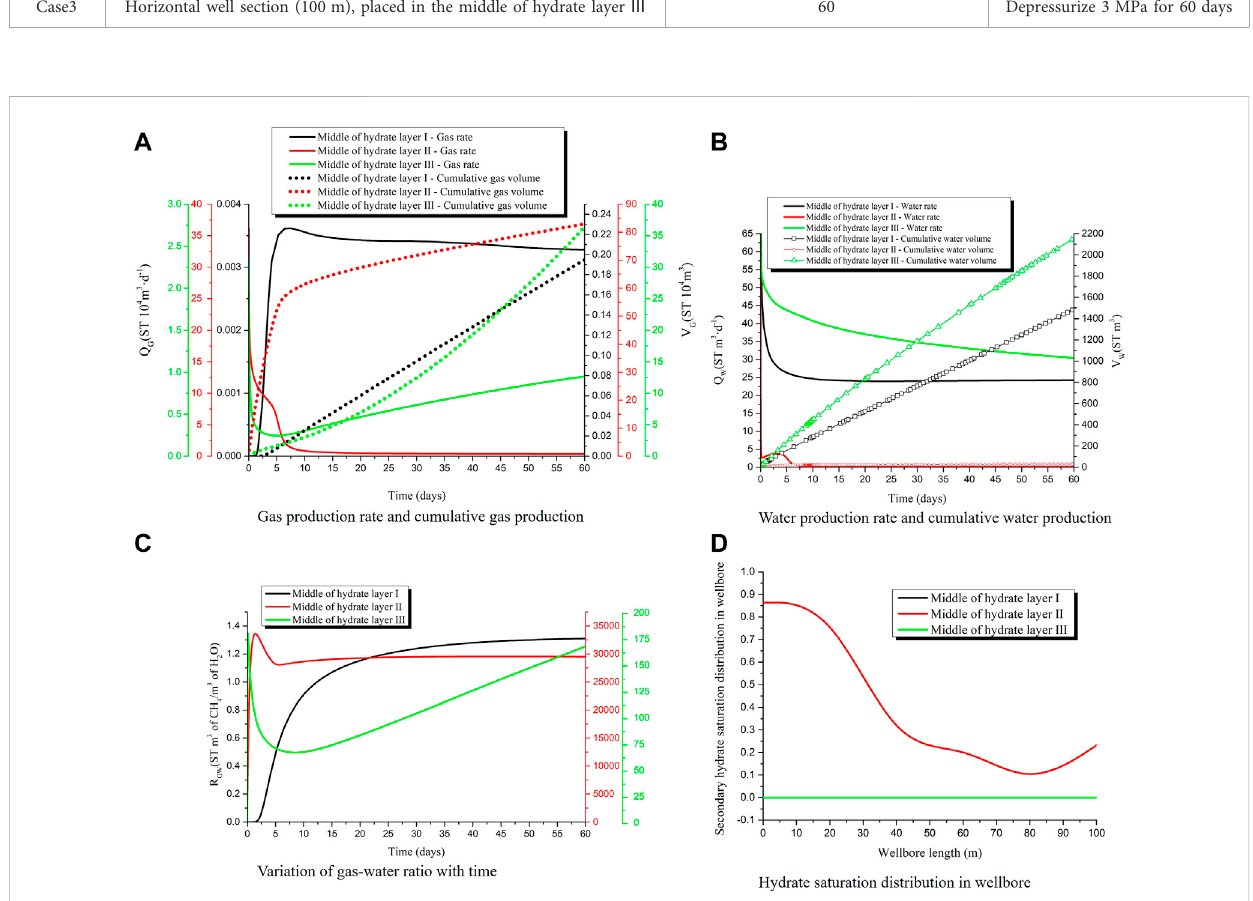
FIGURE 5 Gasproductionrateandcumulativegasproduction (A) ,Waterproductionrateandcumulativewaterproduction (B) ,variationofgas-waterratiowith time (C) , and hydrate saturation distribution in wellbore (D) after 60 days of depressurization production with different